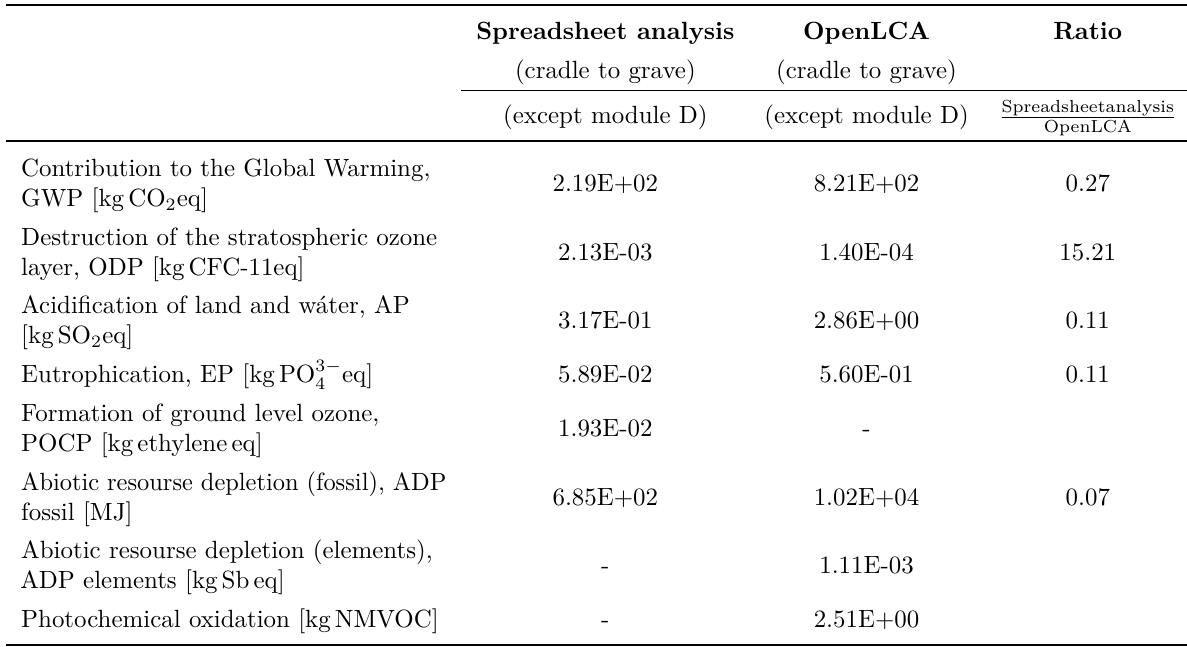
Table 1. Comparison of the environmental impacts obtained according to the calculation made in a spreadsheet and in the OpenLCA software for the same product.